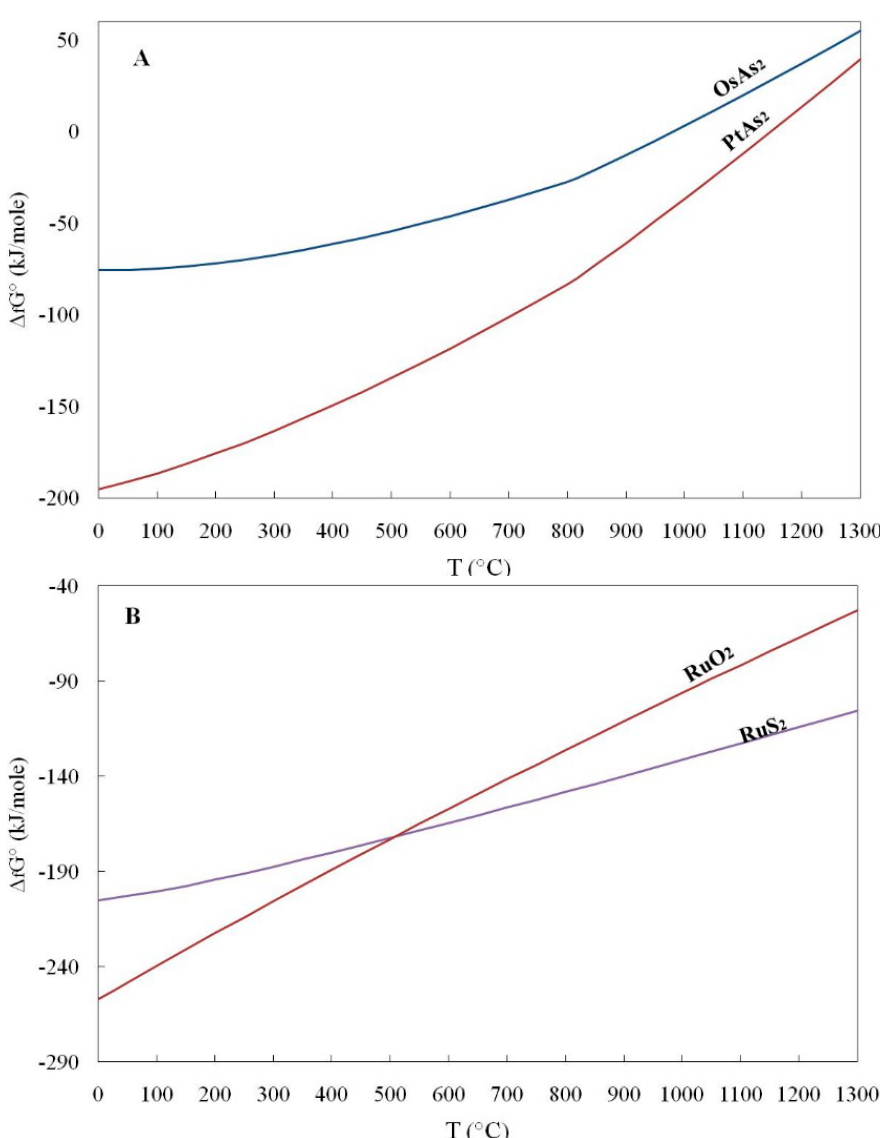
Figure 4. Plot of the free energy ( Δ f G°) against temperature for ( A ) PtAs 2 (sperrylite), OsAs 2 (Omeiite) and ( B ) RuO 2, and RuS 2 (laurite). Data from Table 4.